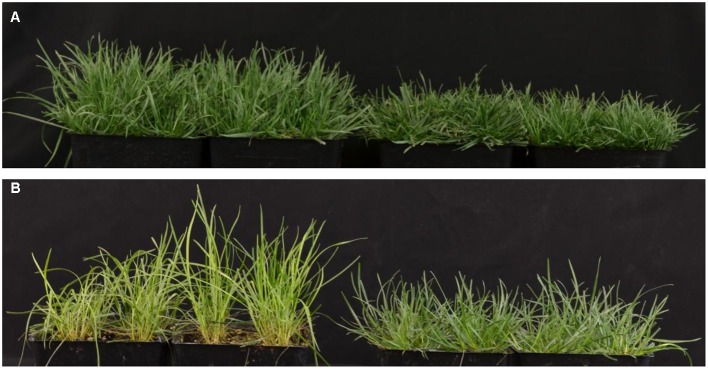
shadow-1 plants exhibit a dual phenotype of dwarfism and shade tolerance. (A) Eight-week-old, wild type (left) and shadow-1 plants (right) grown under full light in the greenhouse. (B) Wild type (left) and shadow-1 plants (right) after 2 weeks under 95% shade in the greenhouse.